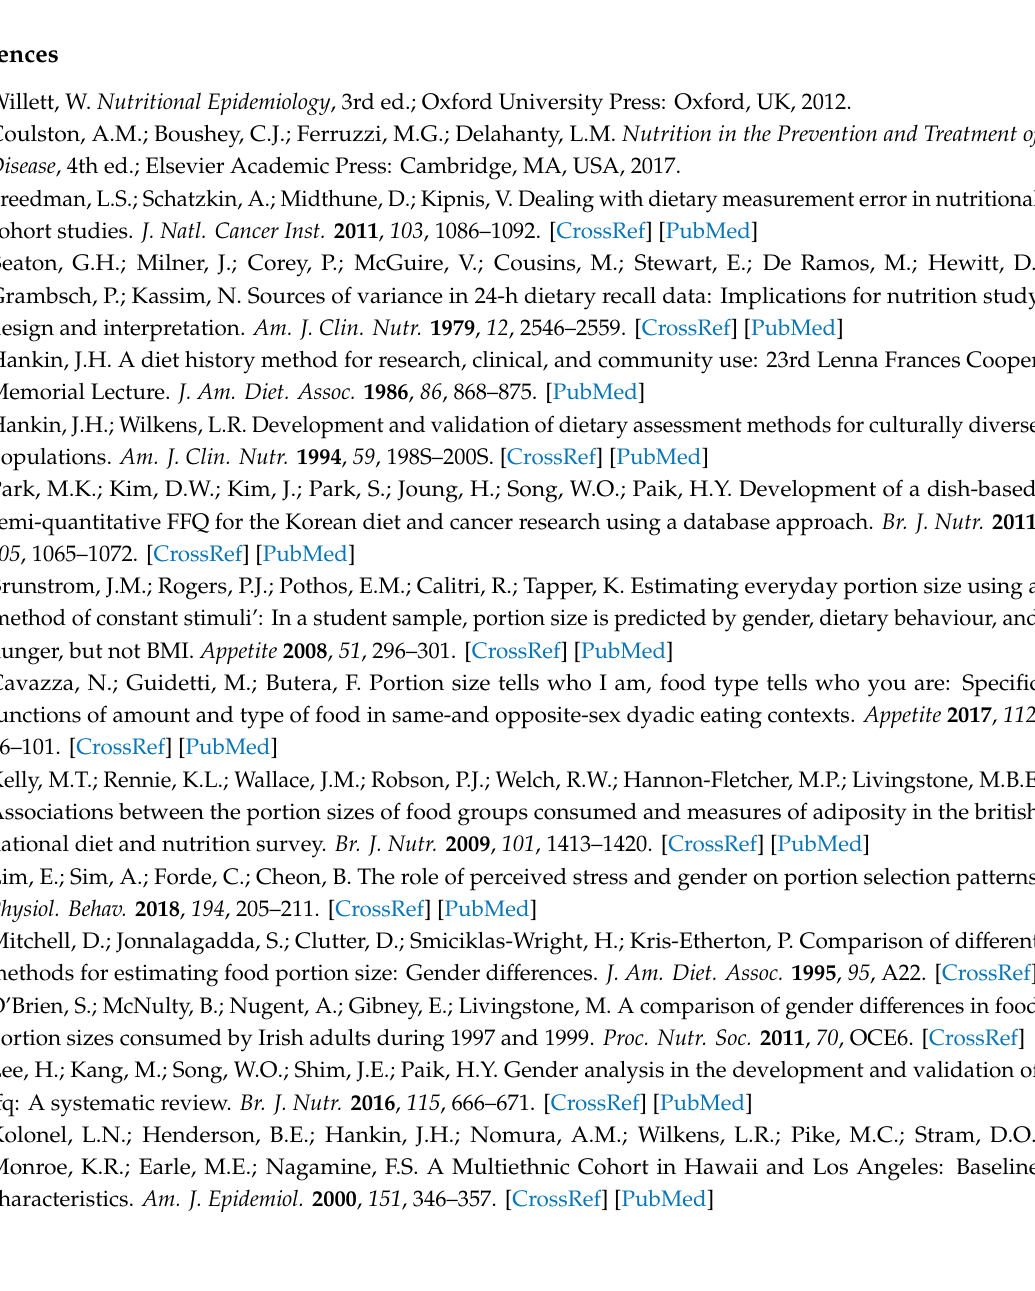
Table S1: Percent of participants in the lowest and the highest quintiles of intakes from the quantitative food frequency questionnaire (QFFQ) with original-portion sizes who belong to the same quintiles from the QFFQ with gender specific-portion sizes in the calibration study of the Multiethnic